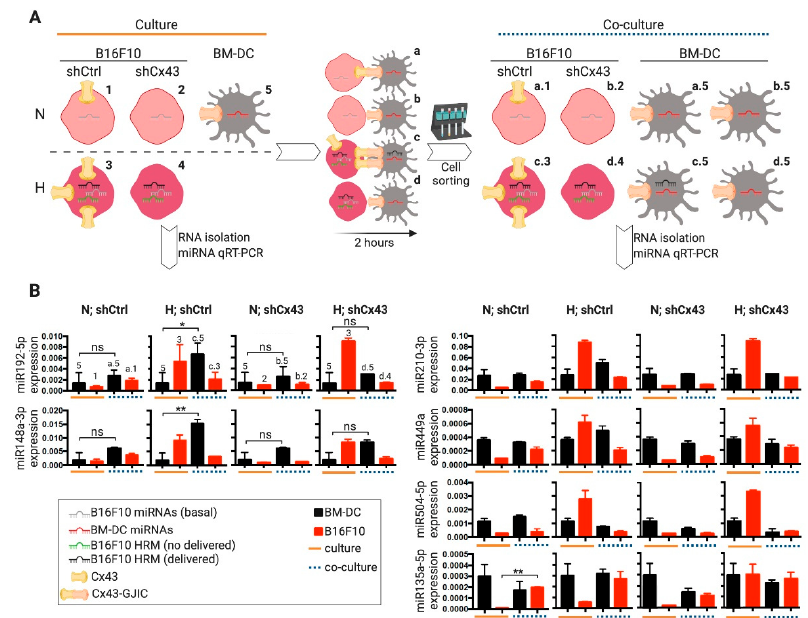
Figure 4. Bone marrow-derived dendritic cells acquire miR-192-5p and miR-148a-3p from hypoxic B16F10 melanoma cells by a Cx43-dependent mechanism. ( A ) Experimental scheme. B16F10 melanoma cells stably transfected with plasmids expressing short hairpin RNAs against Cx43 (shCx43) or control short hairpin (sh) RNAs (shCtrl), were cultured for 24 h upon normoxic (21% O 2 , N) or hypoxic (1% O 2 , H) conditions. Then, the N and H melanoma cells were co-cultured for 2 h with bone marrow-derived dendritic cells (BM-DC) upon a 1:2 cell ratio. After co-culture, BM-DCs were isolated from the co-culture by CD11c + magnetic cell sorting, and CD11c - melanoma cells were also collected. Total RNA samples (including the miRNAs) were isolated from pre-co-culture (named culture, orange lines) and post-co-culture (named co-culture, blue dashed lines) cells and miRNA levels were analyzed by qRT-PCR. ( B ) The levels of miR-192-5p, -148a-3p ( left ), -504-5p, -135a-5p, -449a, and -210-3p ( right ), were evaluated in the cells obtained as described in A (a number and letter code is showed for better comprehension). The miRNA levels were obtained by the Δ / Δ Ct method and normalized to small nuclear RNA RNU6-2. Inset square: legend for ( A ) and ( B ). * p < 0.05; ** p < 0.01; ns: non-significant (two-tailed Student’s t -test).